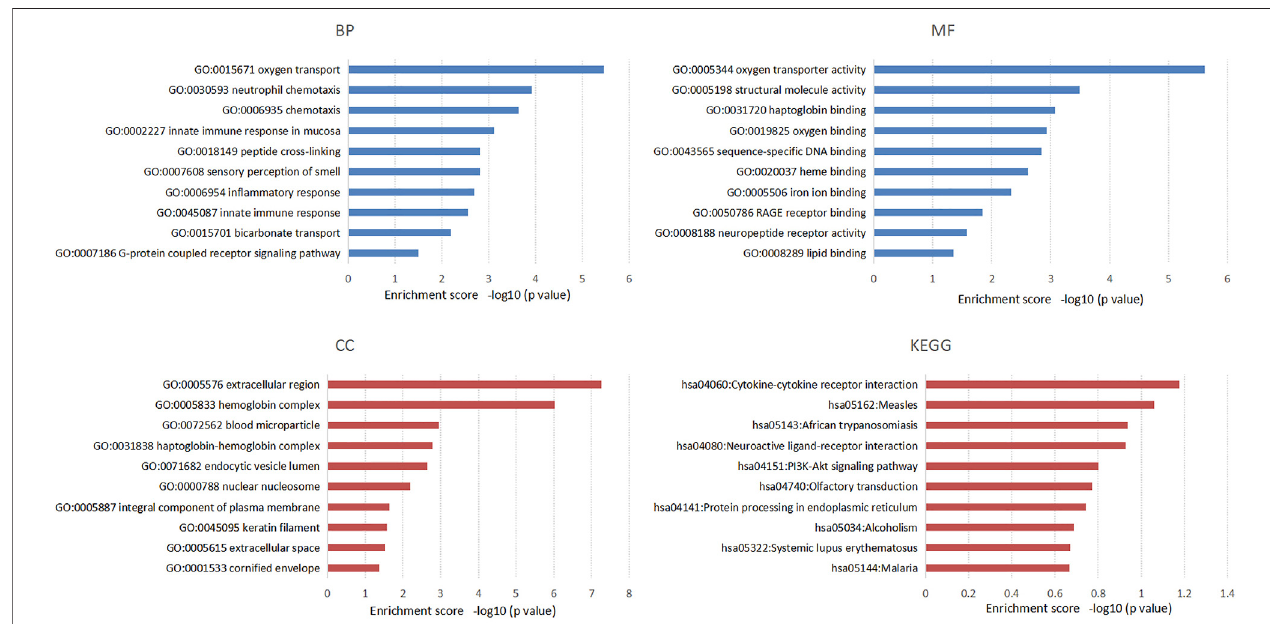
FIGURE 4 | The top 10 enriched items of differential lncRNAs targeted mRNAs in the process of chronic non-atrophic gastritis and gastric mucosal intraepithelial neoplasia to gastric cancer in GO and KEGG enrichment analysis.